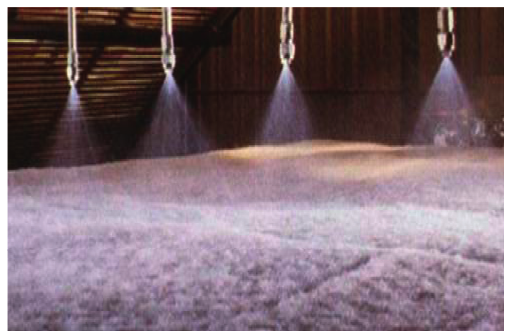
Figure 1: Schematic representation of adhesive